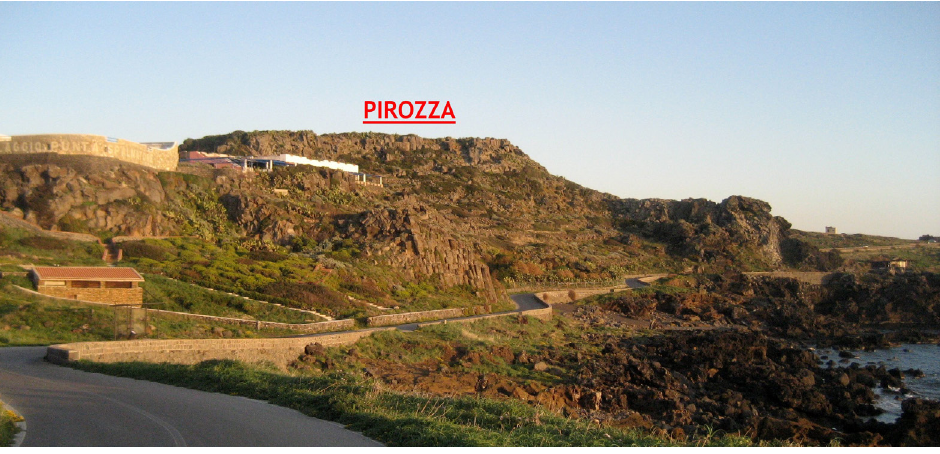
Figure 6. Street view of the Pirozza hill, in the Spalmatore district, as seen from the north. On the left, the area now occupied by the tourist